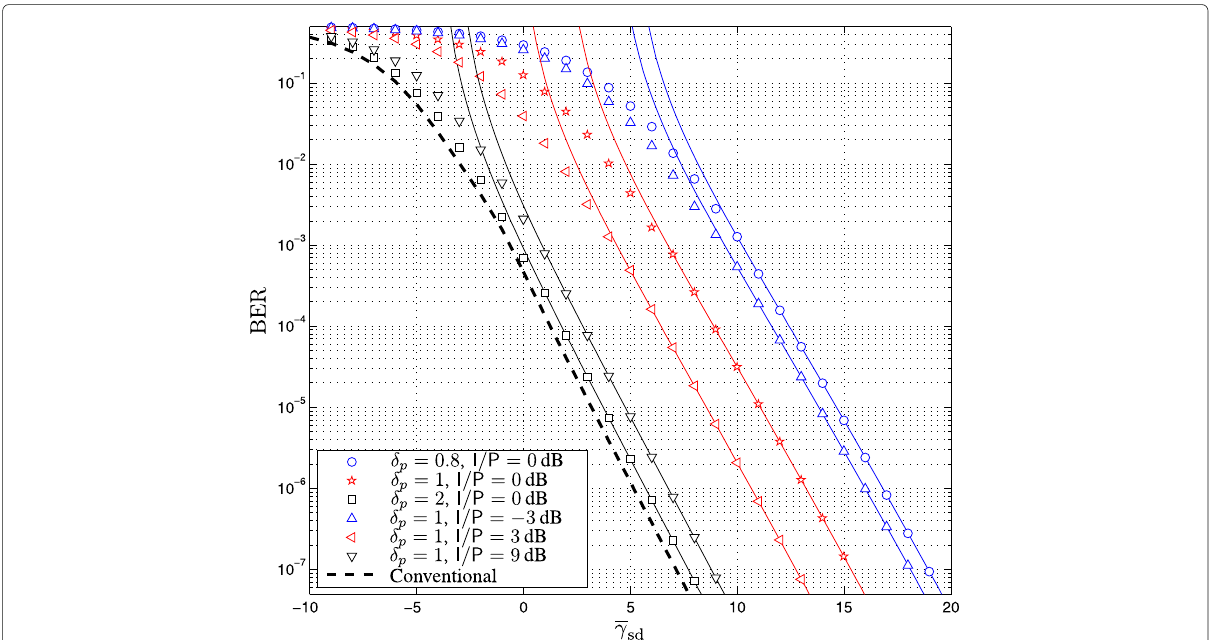
Fig. 4 BER of a two-hop cognitive relay channel as a function of γ sd using a convolutional coding scheme. For different ratios δ p = d rp / d rd and I / P, lines correspond to the analytical results, hollow markers correspond to simulation results. The BER of the conventional two-hop source-relay-destination link is shown as a reference (dashed